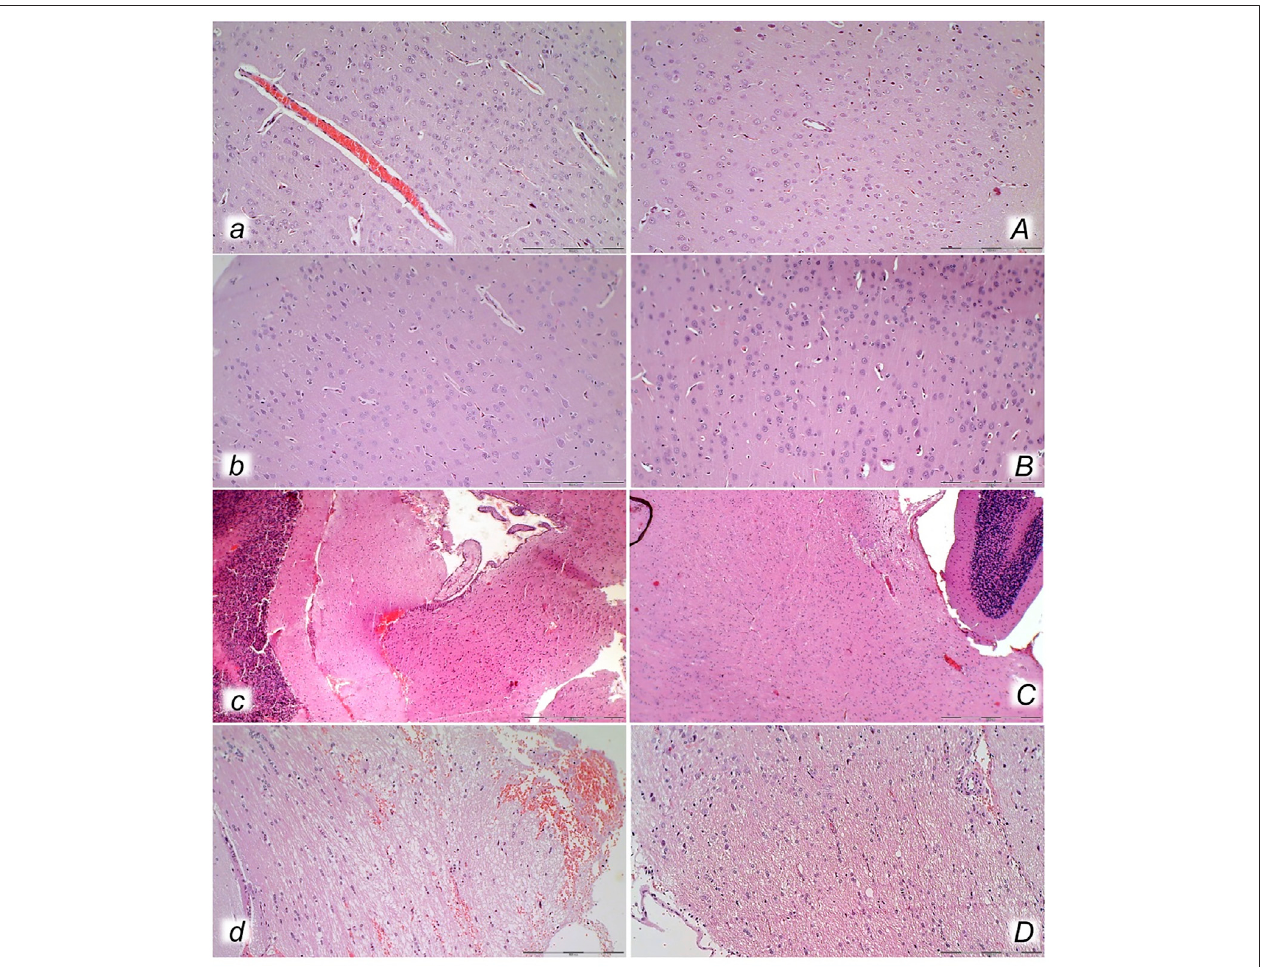
FIGURE 13 | Neuropathological changes of the cerebral cortex ( a, A, b, B ), cerebellar cortex ( c, C ) and pons ( d, D ) in rats with the increased intra-abdominal pressureat25 mmHgfor60 min( a,A,c,C )orat50 mmHgfor25 min( b,B,d,D ),treatedat10 minincreasedintraabdominalpressuretimewithsaline(control, a,b,c,d ) or BPC157 ( A, B, C, D ). Generalized edema and congestion ( a, b,c, d ) with anincreased number ofkaryopyknotic cells werefound in the cerebral cortex ( a, b ) thatwas signi fi cantly different from the cortex area in BPC 157-treated rats ( A, B ). In control rats, intracerebral hemorrhage was found in infratentorial space ( d ), mostly in cerebellopontine angle/area ( c ) with generalized edema and congestion of central nervous system, while no hemorrhage ( C ) and only mild edema was found in treated animals, mostly at 50 mmHg intra-abdominal pressure ( D ). (HE; magni fi cation × 200, scale bar 100 μ m ( a, A, b, B, d, D ) ; magni fi cation × 100, scale bar 200 μ m ( c, C )).